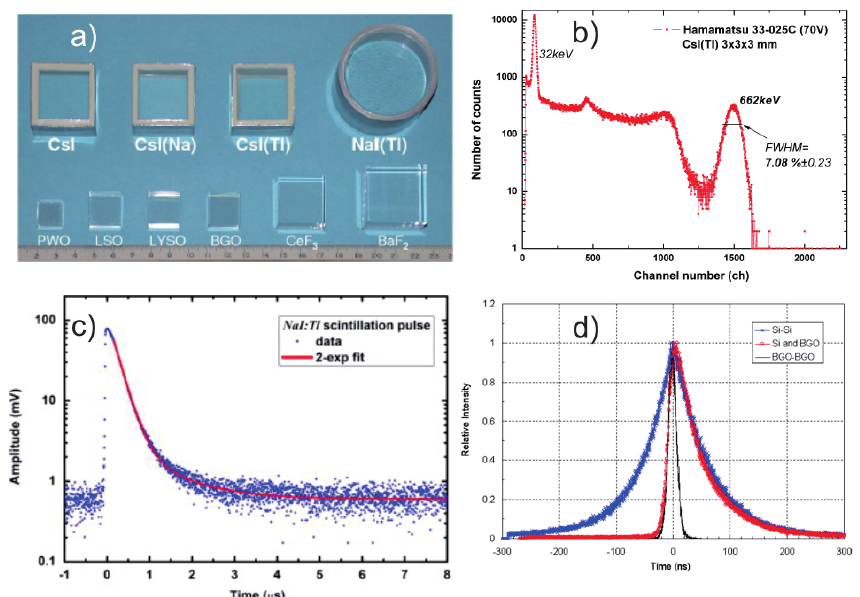
Figure 2. Inorganic and organic traditional scintillators: ( a ) A photo showing traditional scintillators. ( b ) Energy spectrum of 662 keV gamma rays from a 137 Cs source, as measured with CsI : Tl + crystals 3 × 3 × 3 mm 3 . ( c ) Scintillation decay curve recorded for NaI : Tl irradiated with a 137 Cs source.